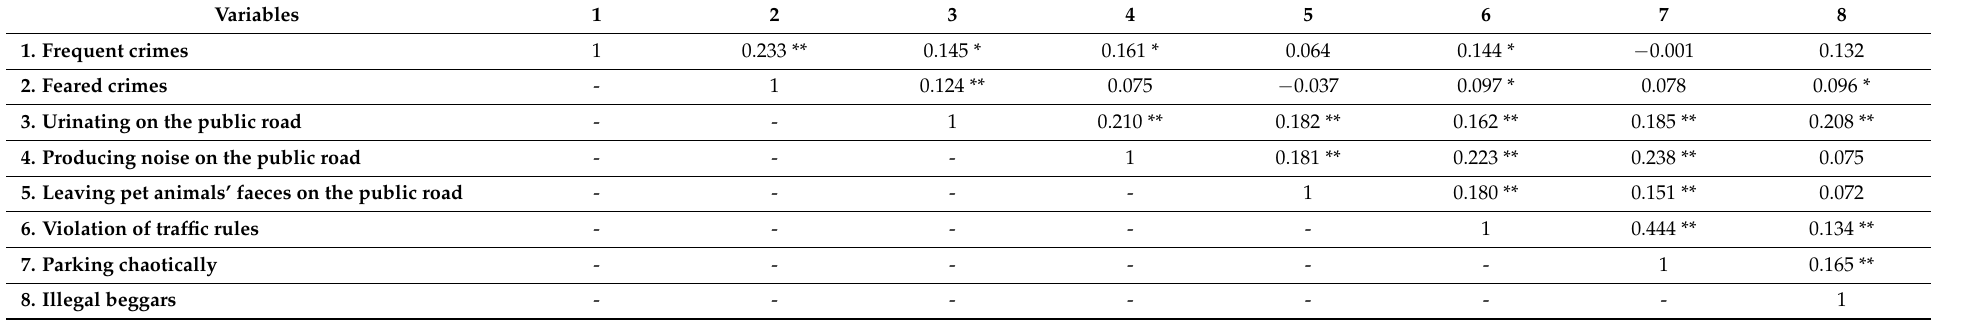
Table 3. Spearman correlations between frequent and feared crimes, and incivilities in the territory.